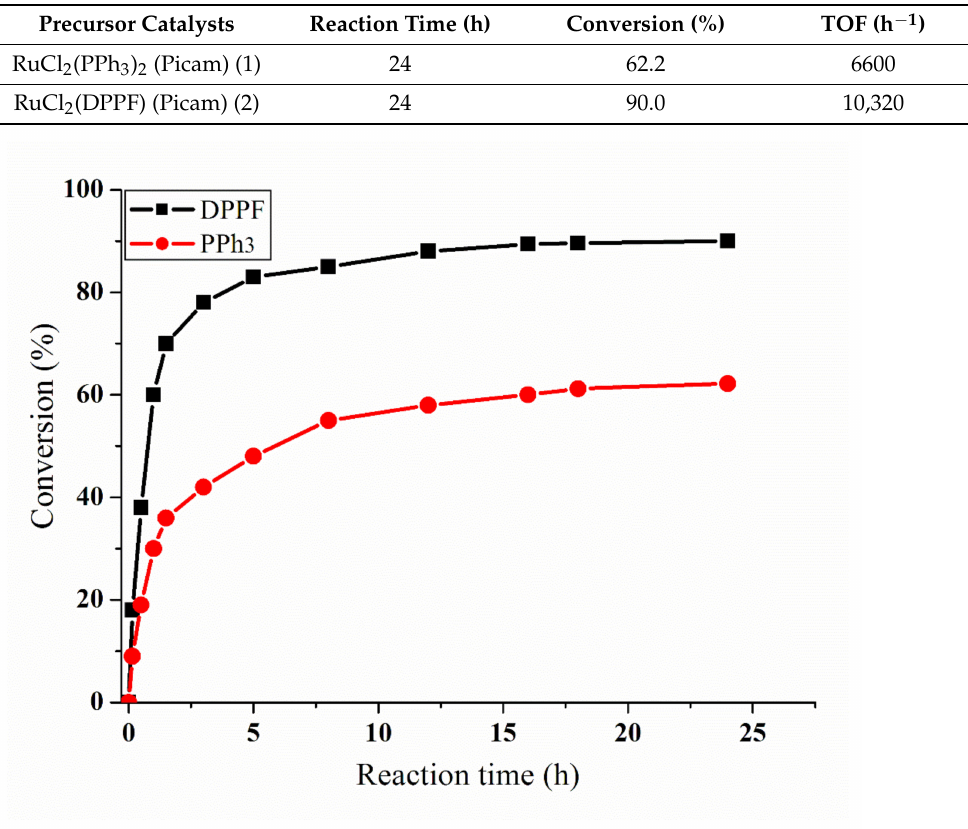
Figure 4. Conversion versus reaction time for complexes 1 and 2 under the condition given in the experimental